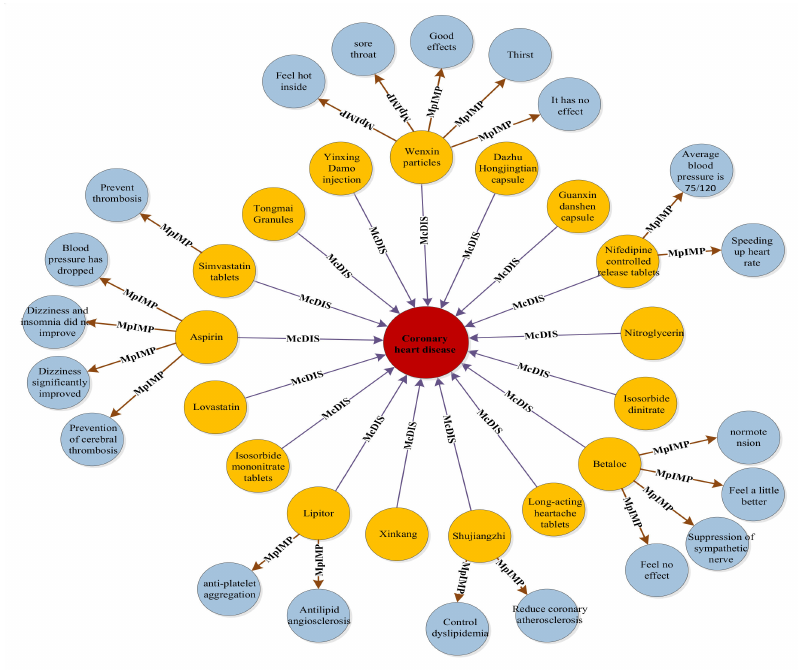
Figure 4. Drugs and drug effects related to coronary heart disease.